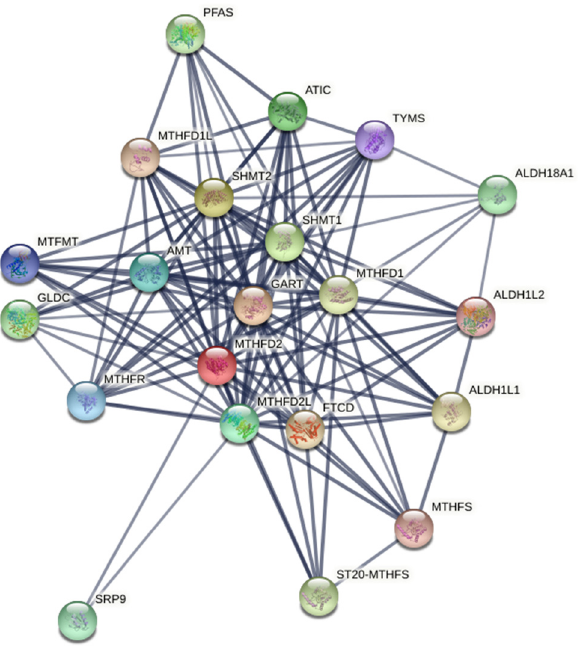
Figure 3: The protein – protein network for MTHFD2 and rele - vant